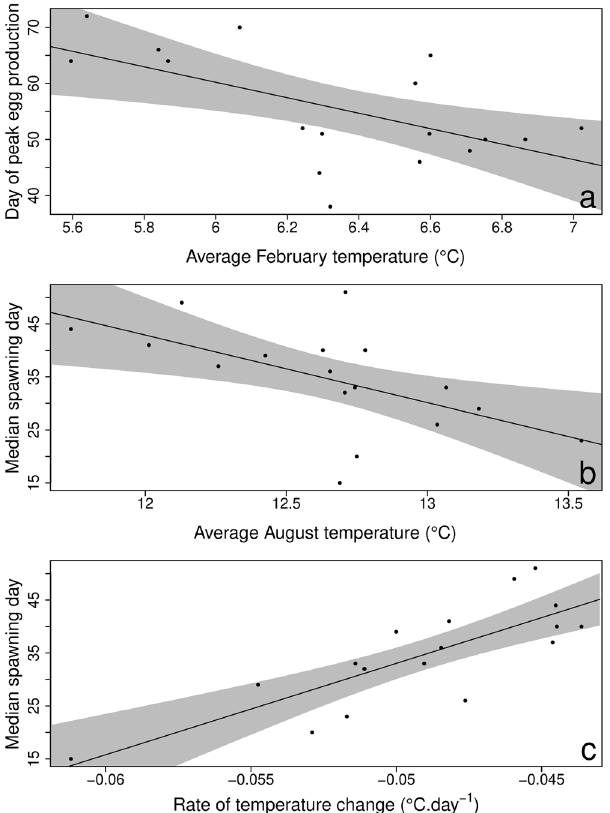
Figure 2. Relationships between predator-prey phenologies and environmental variables. ( a ) Influence of average February temperature on C . helgolandicus peak egg production. Effect of ( b ) average August temperature and ( c ) the rate of temperature decrease (September to February) on sandeel median spawning